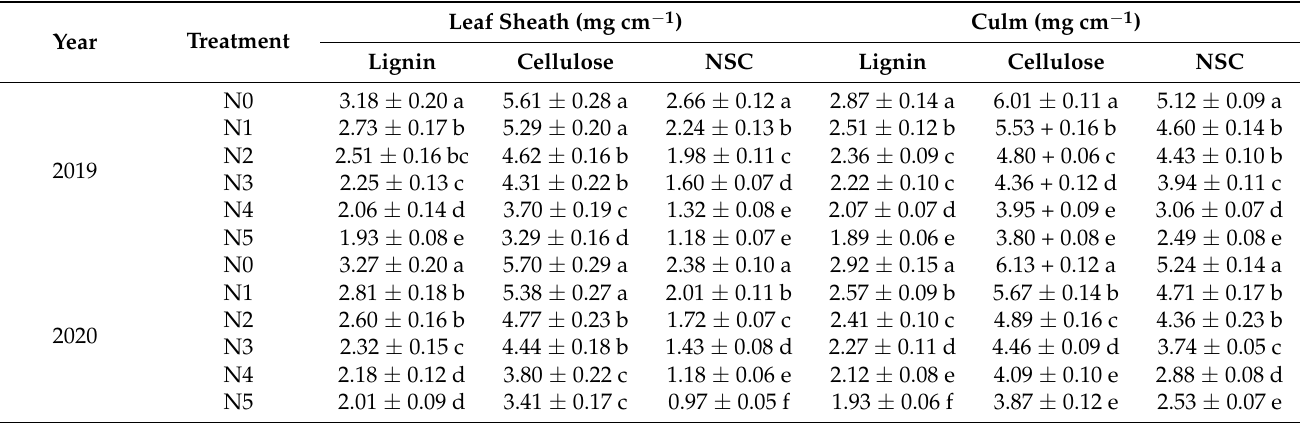
Table 7. Effect of N application rate on carbohydrates contents of the S2 basal internode of the culm and sheath of rice under dry cultivation in 2019 and 2020.